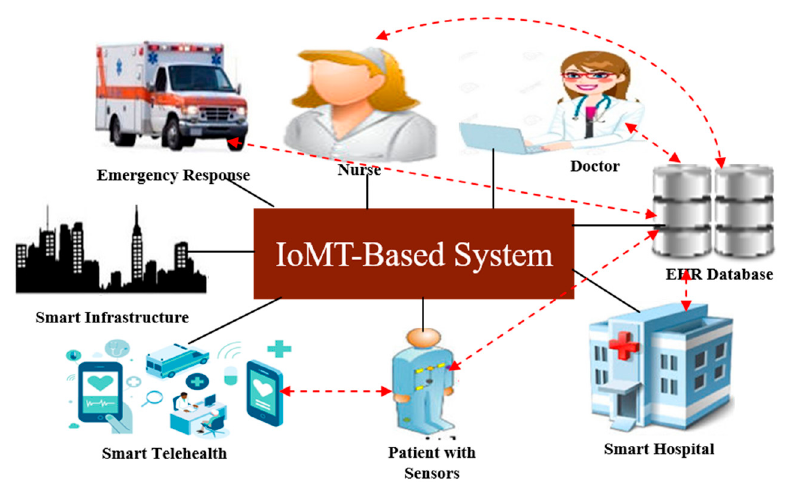
Figure 1. IoMT-based interventions in a smart healthcare system.